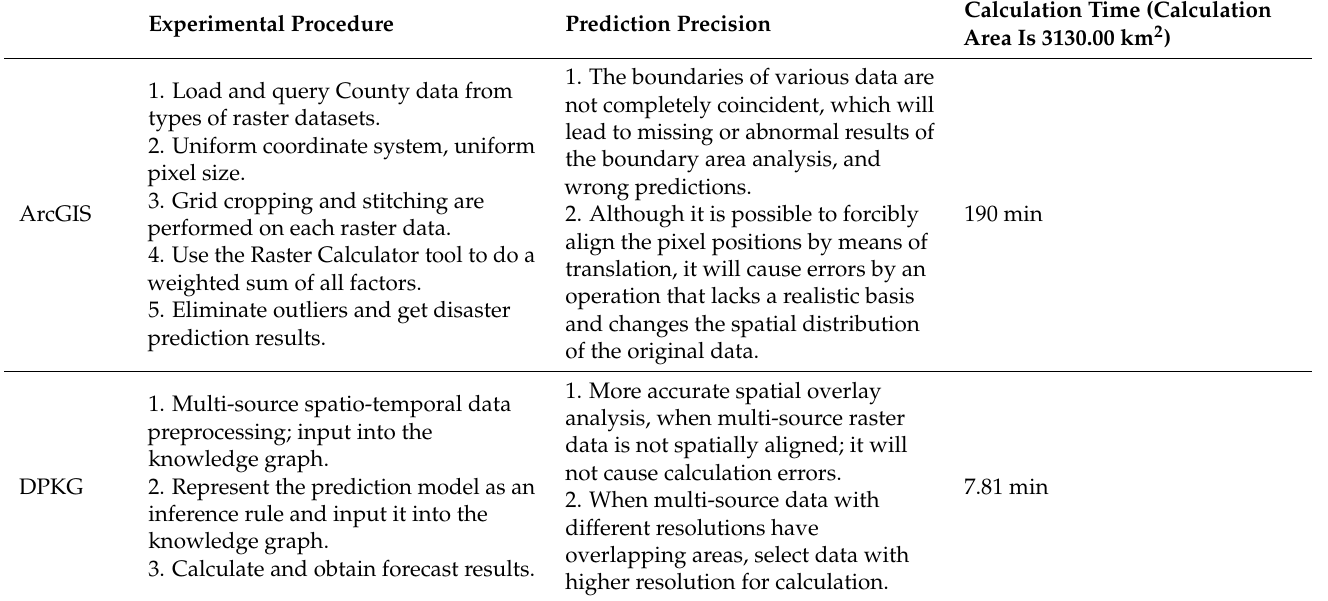
Table 2. Comparison of DPKG and ArcGIS. Experimental